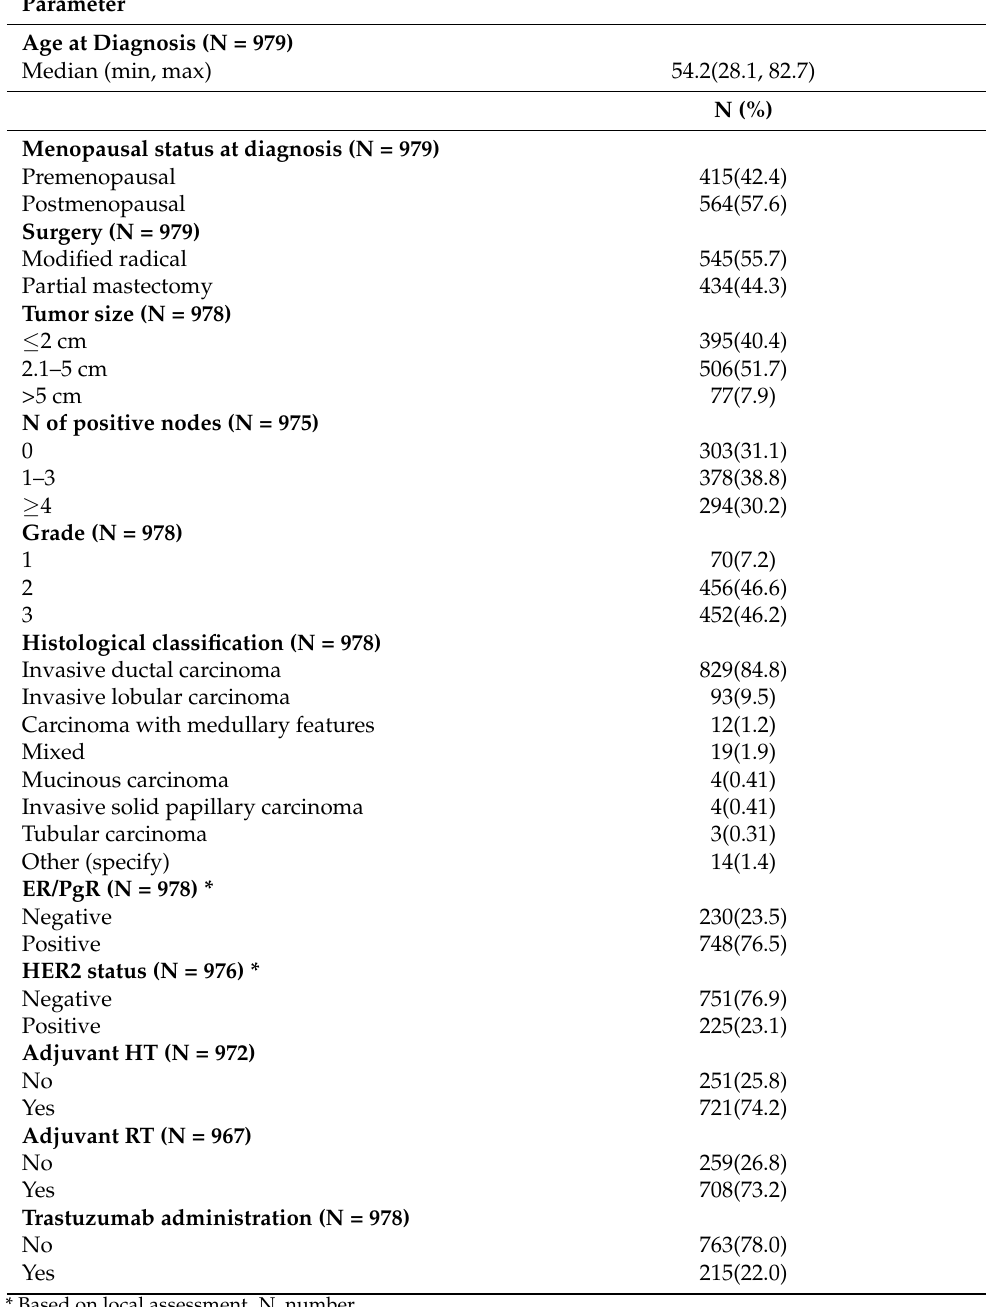
Table 1. Patient and tumor